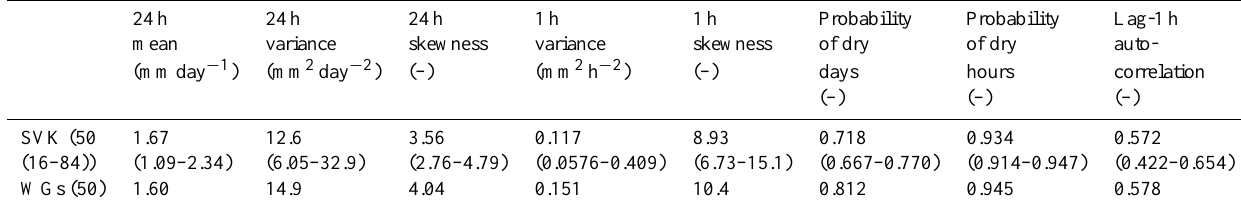
Table 4. Comparison between observational (SVK) data and the simulated (WGs) statistics. Data are averaged over the full course of the year and over the full model domain. For the SVK data set the 50th percentile (50) is reported as well as the 16th to 84th percentiles (16–84) interval to emulate the empirical standard deviation. For the WGs one central 50th percentile is reported across the ten simulations.